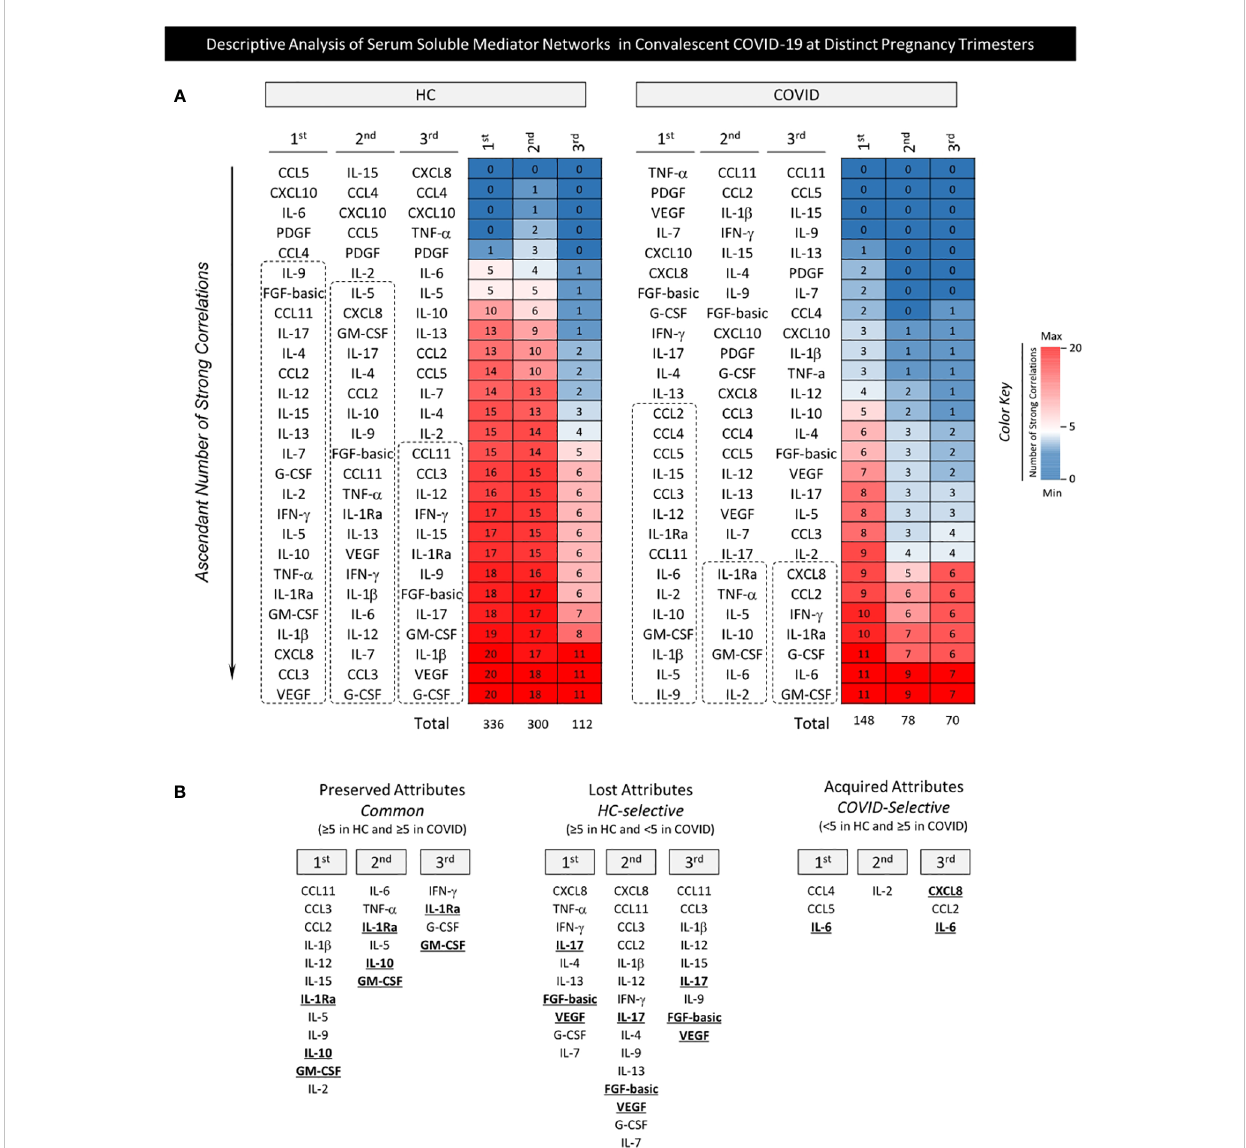
FIGURE 5 Descriptive analysis of serum soluble mediator networks in convalescent COVID-19 patients at distinct pregnancy trimesters. The overall pro fi le of serum soluble mediator networks was assessed in pregnant women with convalescent COVID-19 at 3-20 weeks after symptoms onset (COVID, n=89) with pre-pandemic non-infected pregnant women as a Healthy Control (HC, n=52). The HC and COVID-19 groups were further categorized into subgroups according to pregnancy trimester, referred to as: 1 st (HC=21 and COVID=7), 2 nd (HC=10 and COVID=34), and 3 rd (HC=21 and COVID=48). (A) The ascendant number of strong correlations was arranged to identify the set of biomarkers with fi ve or more ( ≥ 5) strong correlations with other molecules at each pregnancy trimester in HC and COVID subgroups. Heatmap constructs were assembled to illustrate the overall pro fi le of serum soluble mediator networks of COVID and HC subgroups along the pregnancy trimesters. A color key was used to underscore the serum soluble mediators with ≥ 5 strong correlations (towards red). (B) A summary of preserved ( ≥ 5 in HC and ≥ 5 in COVID), lost ( ≥ 5 in HC and <5 in COVID) or acquired (<5 in HC and ≥ 5 in COVID) attributes were identi fi ed by Venn diagram analysis. Attributes identi fi ed along the trimesters are highlighted by bold underline